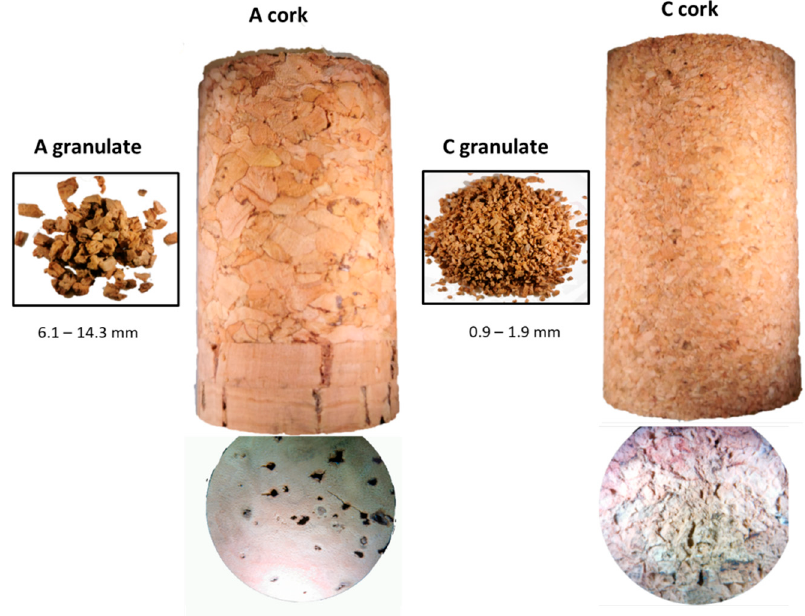
Figure 1. Representative image of the studied granulates and cork stoppers (A, high particle size and C, low particle size).